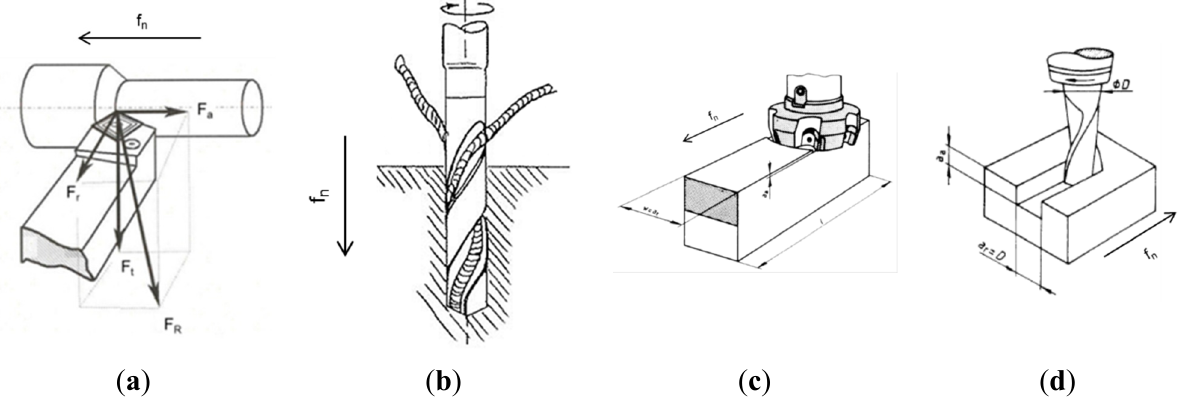
Figure 4. Some typical machining processes, ( a ) longitudinal turning [7]; ( b ) twist drilling [8]; ( c ) face milling [9]; ( d ) slot milling